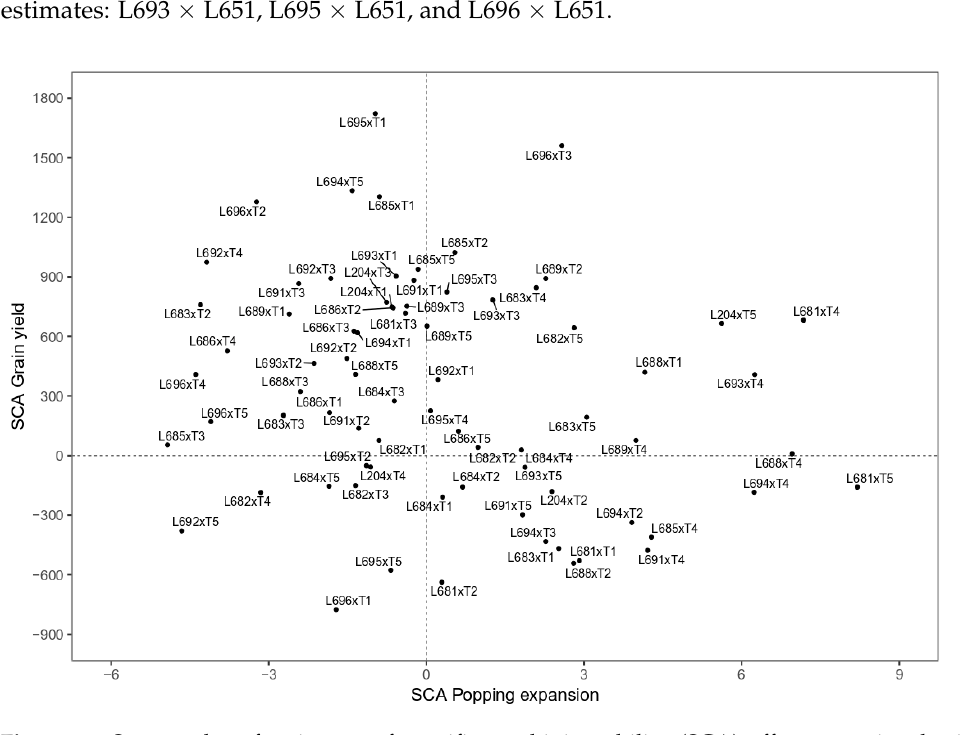
values were L204 × L651, L204 × PARA 172, L204 × L270, L685 × P1, and L694 × PARA 172 (Table